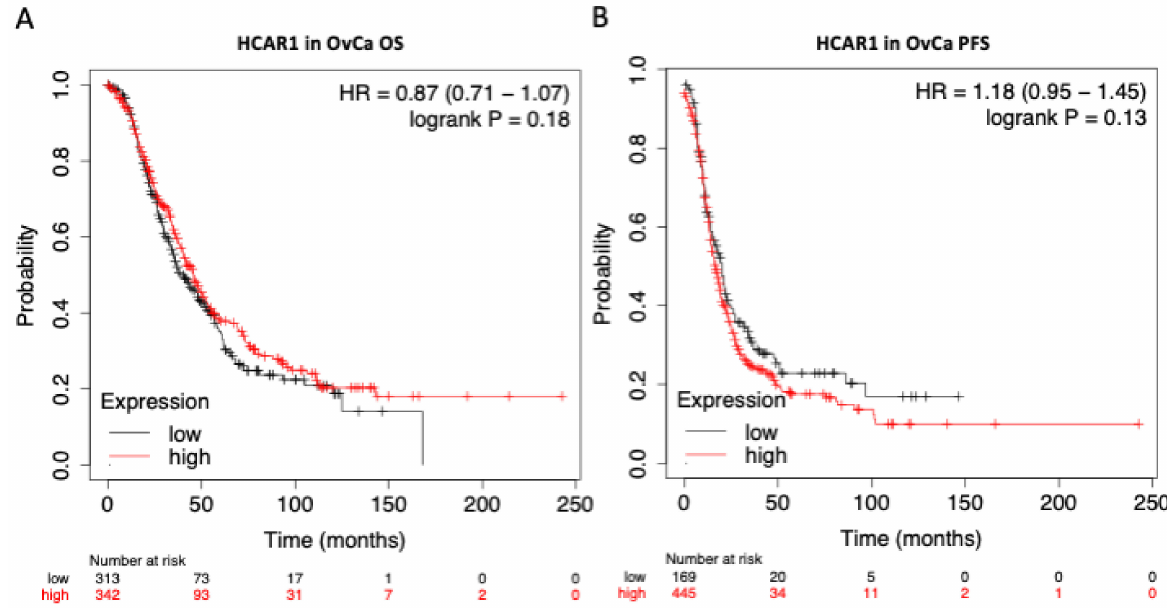
Figure 5. Ovarian Cancer (OvCa) Survival Curve analysis. Kaplan–Meier plots revealing the prog- nostic effects of HCAR1 expression in OvCa; ( A ) overall survival (OS); ( B ) progression-free survival (PFS). Generated through the Kaplan–Meier plotter